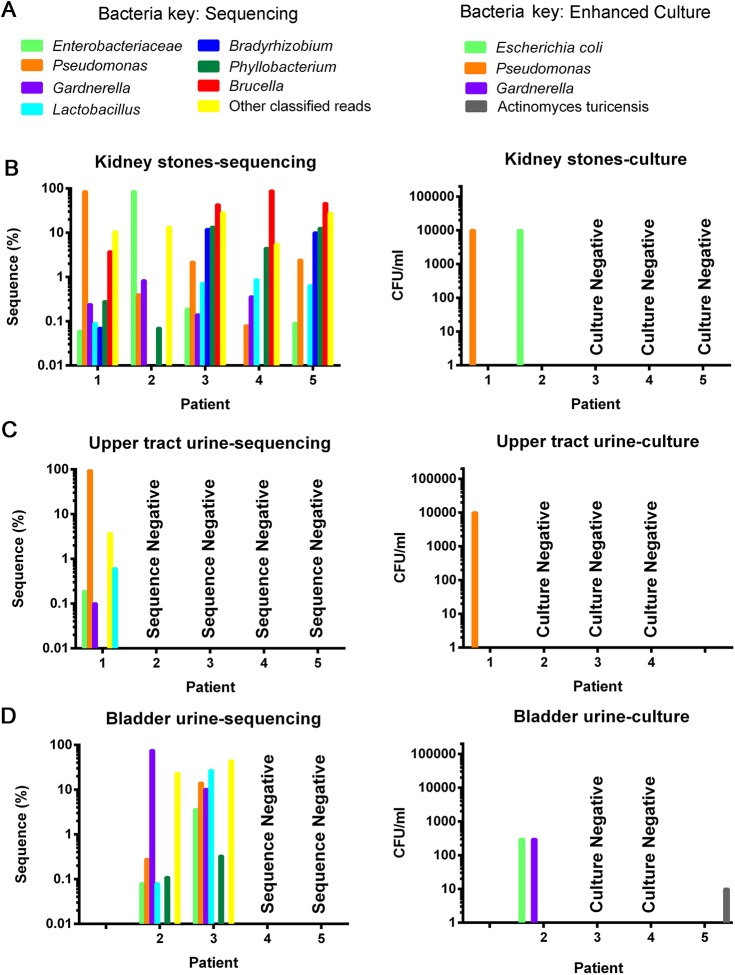
Kidney stones contain bacteria and/or DNA.(A) Bacteria key. (B) All stones contained multiple bacterial taxa on sequencing (left column) Bacteria identified included the family Enterobacteriaceae (which includes E. coli), and the genera Pseudomonas, Gardnerella, Lactobacillus, Brucella, Phyllobacterium and Bradyrhizobium. Bacteria were cultured (right column) from 2 stones and represented the most abundant bacteria identified by sequencing. (C) Bacteria were only sequenced and cultured from upper tract urine in 1 patient. (D) When detected in the bladder urine, the taxa were similar to those observed in the stones, although the ratios were often dissimilar. To allow low percentage organisms to be visualized, the data was graphed on a logarithmic Y-axis.